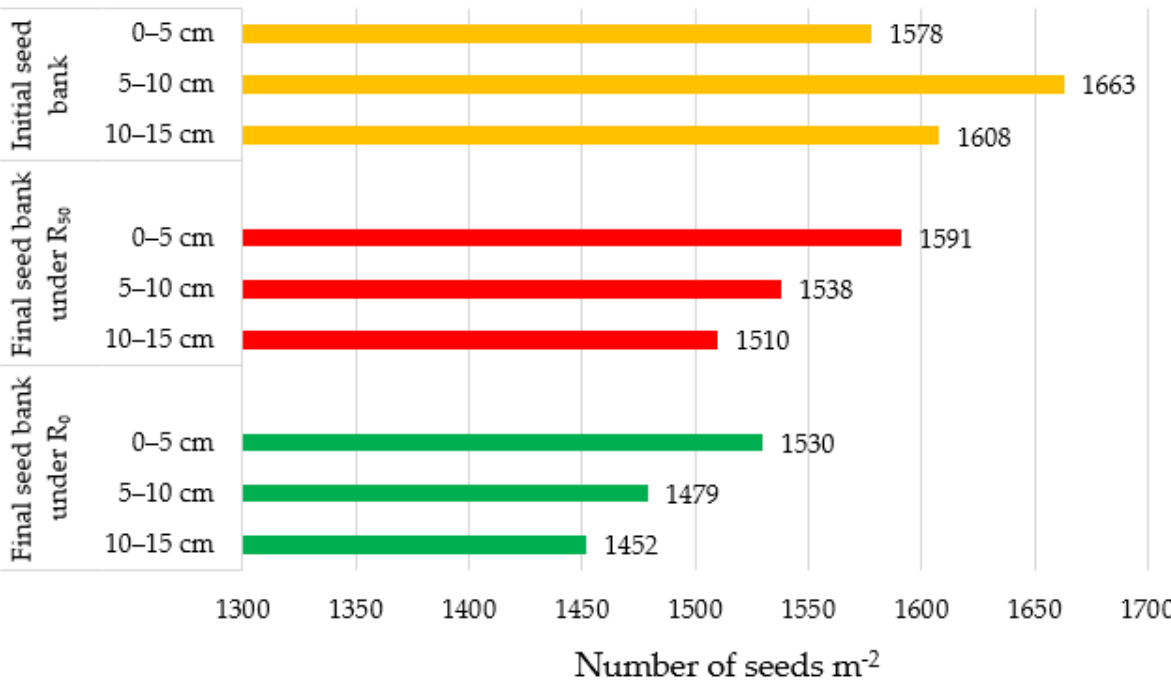
Figure 5. Vertical distribution of seeds at 0–5, 5–10, and 10–15 cm soil depth under mulched and non-mulched conditions (mean from two crop rotations).